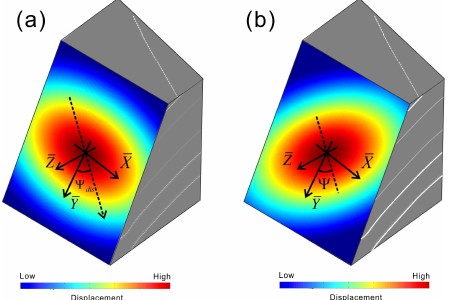
Figure 4. Demonstration of fault displacement distribution. ( a ) Near-field displacement with dis- placement rotation angle Ψ dis . ( b ) Near-field displacement with attenuation rotation angle Ψ . The dashed arrow indicates the direction of displacement, and the dotted line indicates the direction of the short axis of the attenuation ellipse.